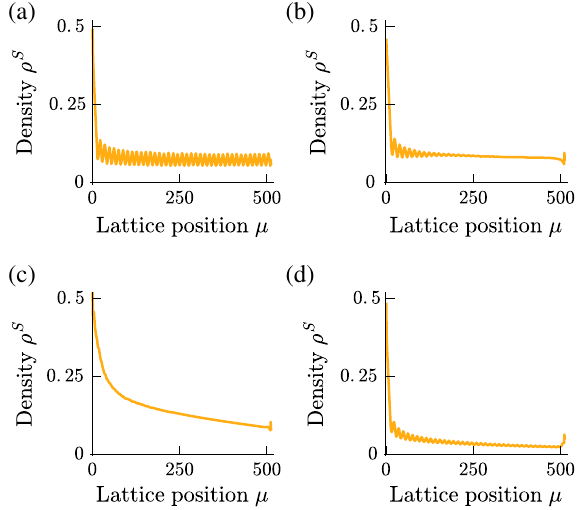
FIG. 20. Effects of model extensions on density patterns. (a) Dimers show the same kind of density patterns as monomers. (b) If lane-switching dimers do not follow a unique trajectory ( θ ¼ 0 . 95 ), density patterns occur but are subject to spatial decay. (c) As soon as dimers are allowed to attach randomly on the lattice ( ω S a ¼ ω T a ¼ 5 × 10 − 5 ), the system loses its characteristic length scale and the density profile becomes smooth. (d) Random tion of density patterns. While the wavelength stays the same, the amplitude of the oscillations is reduced. Other parameters include